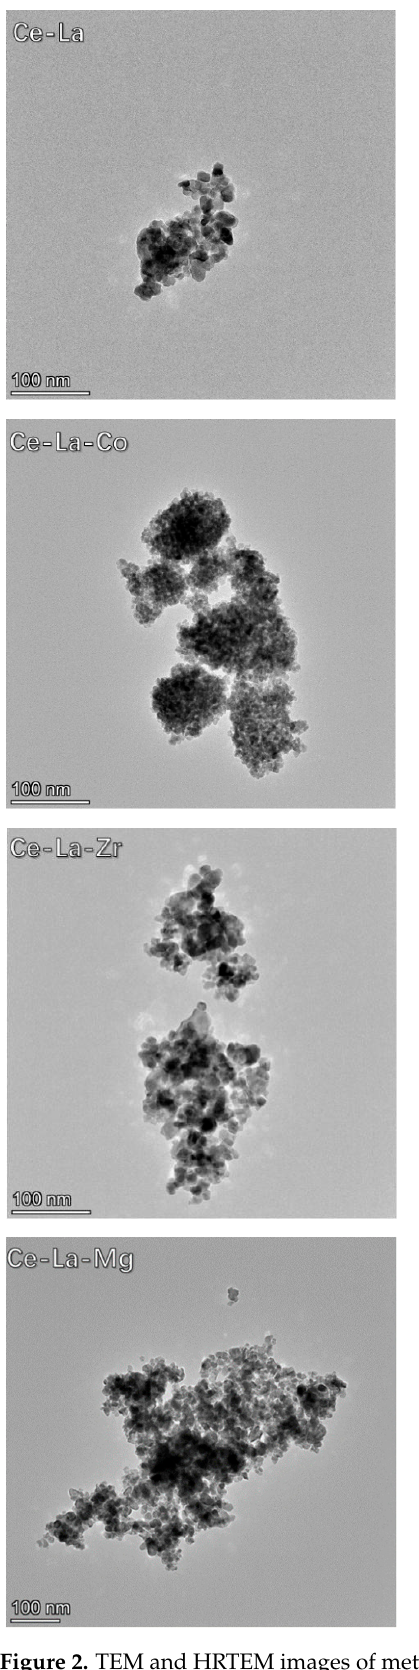
Figure 2. TEM and HRTEM images of metal ion doped cerium lanthanum solid solution.